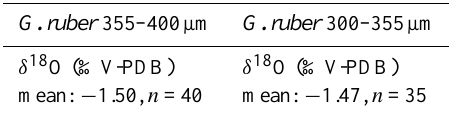
Table 2b. Oxygen isotopes of G. ruber in two different size frac- tions from core 905B, 0–1cm.